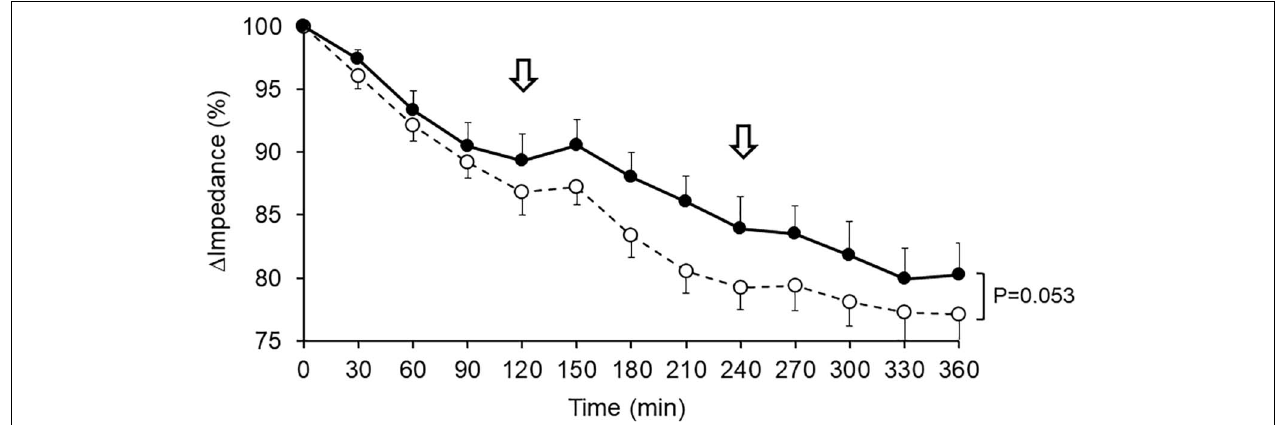
FIGURE 2 | Changes in impedance of the lower leg after 1,000 mg of G-Hsp ( • ) and Placebo ( ◦ ) beverage ingestion. The arrow indicates the walking for urination, mean and SE, n = 6.